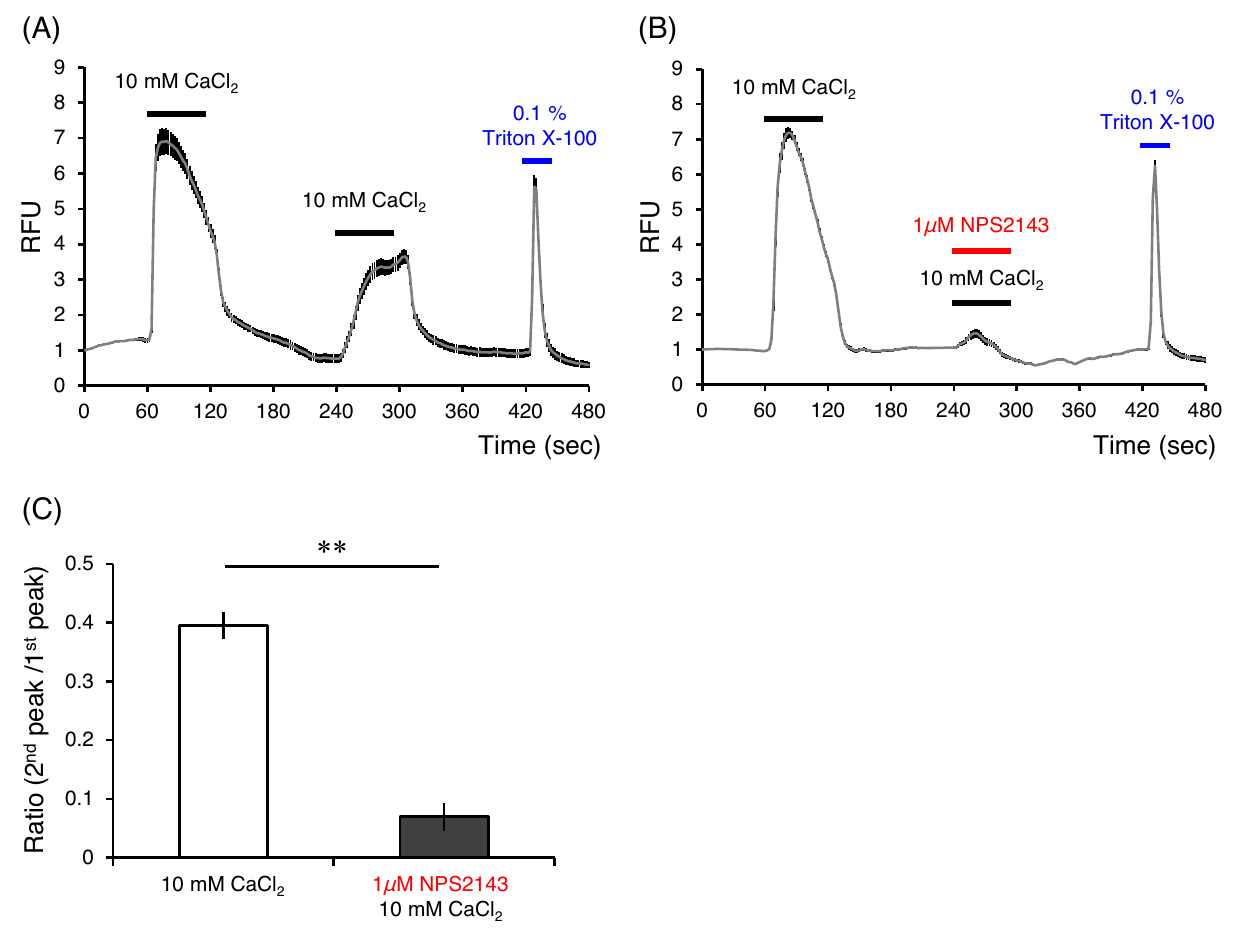
Figure 6. NPS2143 negatively modulated cCaSR activities with 10 mM CaCl 2 . ( A ) Ten mM CaCl 2 activated cCaSR, but the activation by the second stimulus was desensitized. ( B ) The first stimulus by 10 mM CaCl 2 activated cCaSR, but the activation by the second stimulus was negatively modulated by 1 μM NPS2143. ( C ) The ratios of the second peak values to the first peak values of ( A ) and ( B ). NPS2143 significantly reduced 10 mM CaCl 2 -induced cCaSR activation. RFU: relative fluorescence units, the index of cytosolic Ca 2+ concentration. Data are means ± SE (n = 70–100 cells). ** P < 0.01 by unpaired t